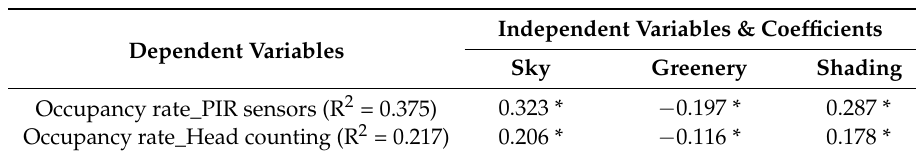
Table 3. Regression models for occupancy rates.